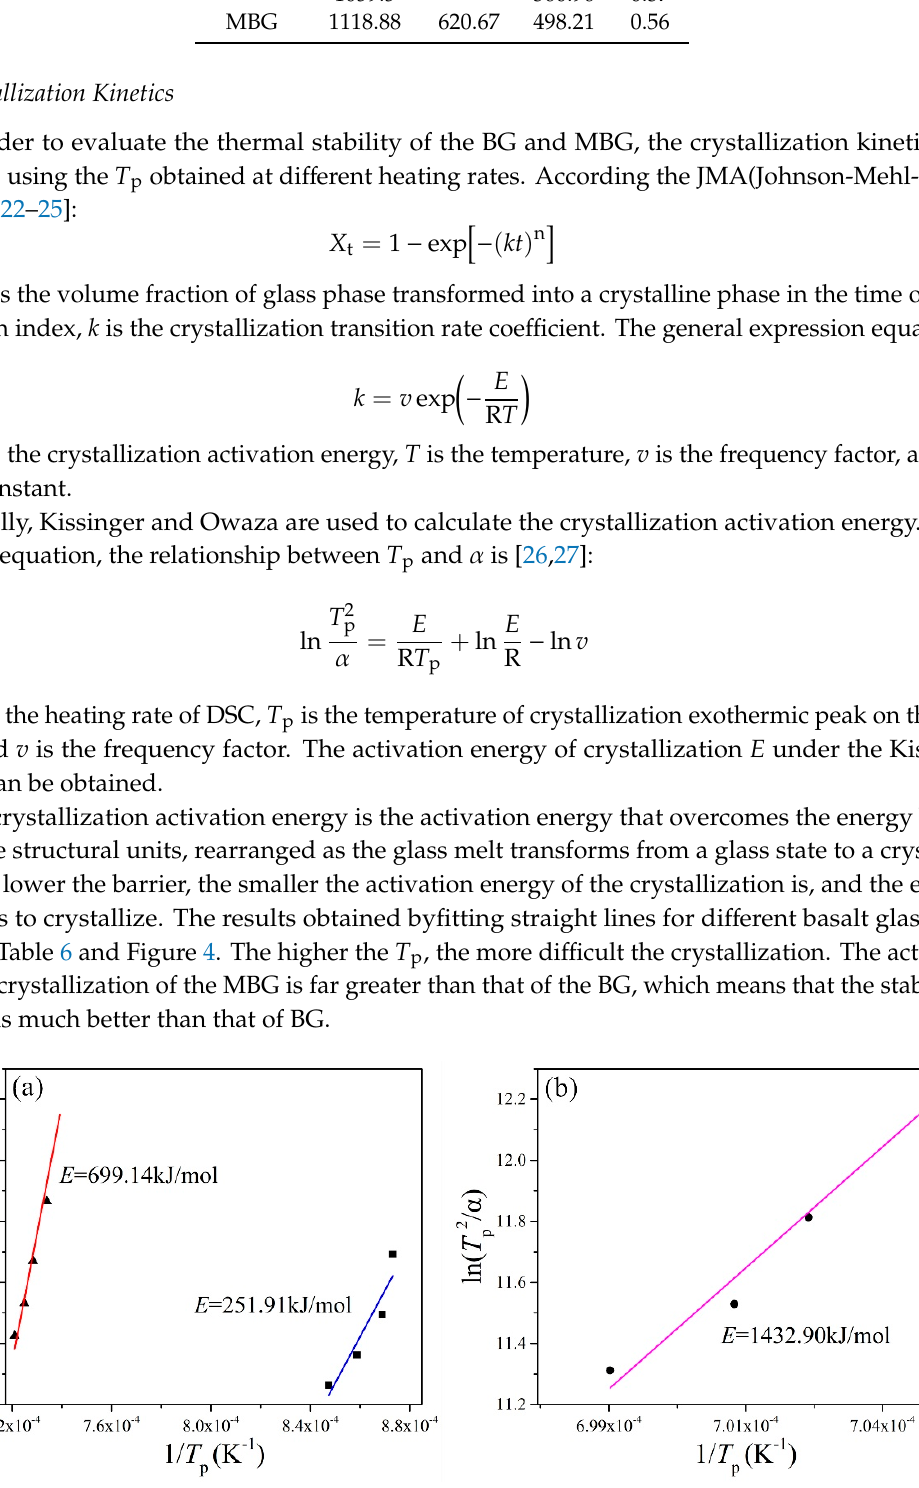
Figure 4. ln( T 2 p / α ) ∼ 1/ T p fitting line of the ( a ) BG and ( b )MBG.